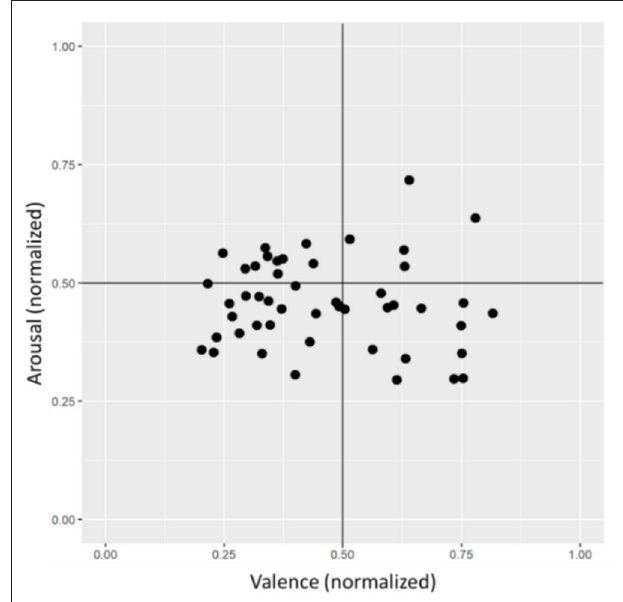
FIGURE 6 | Scatterplot of the average general emotion of all subjects across the